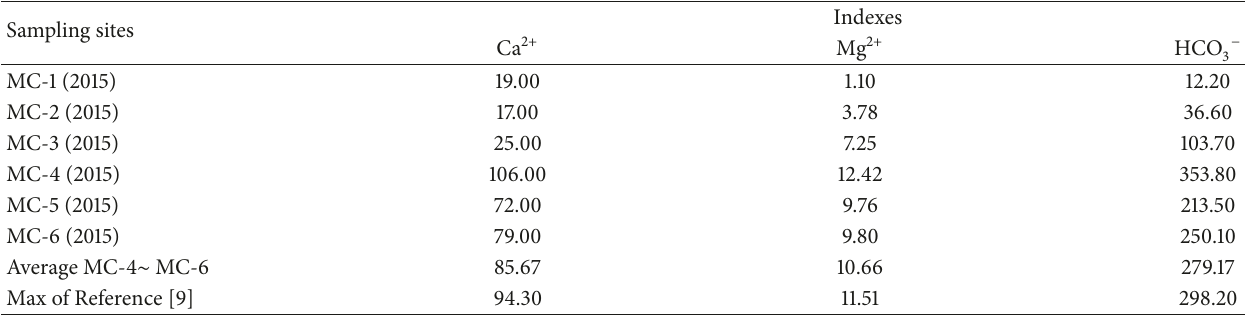
Table 4: Comparison of the main indexes in the Maocun subterranean river basin (mg.L − 1). Sampling